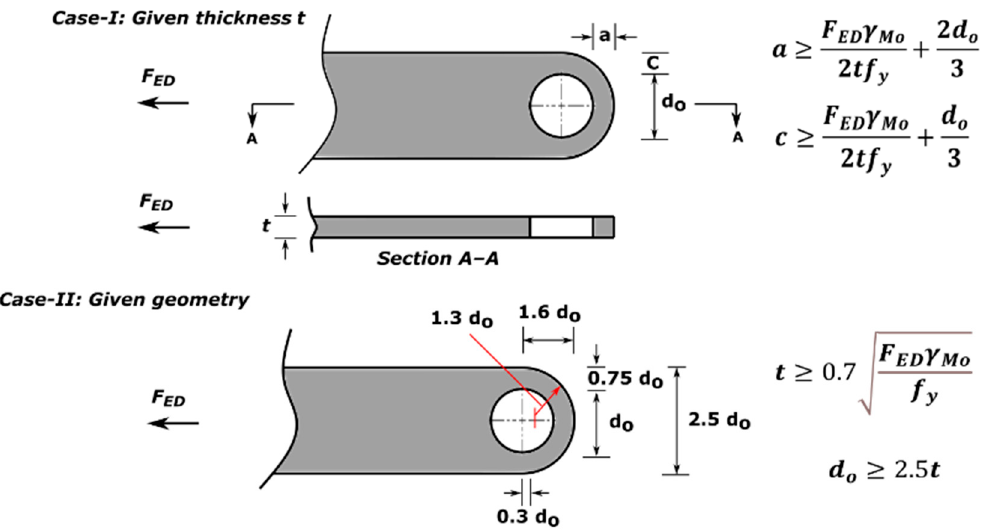
Figure 7. Edge distance and end distance requirement for pin connection according to EN 1993-1-8 [13].